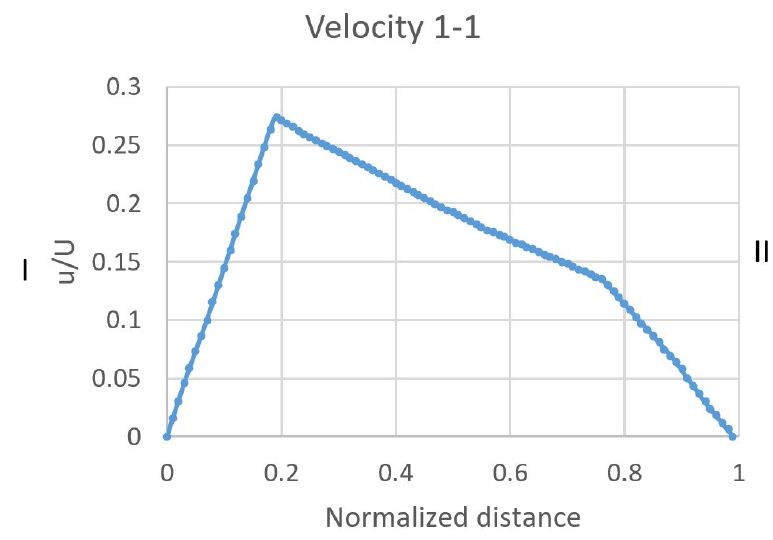
Figure 8. Velocity profile at the upstream section (1-1).